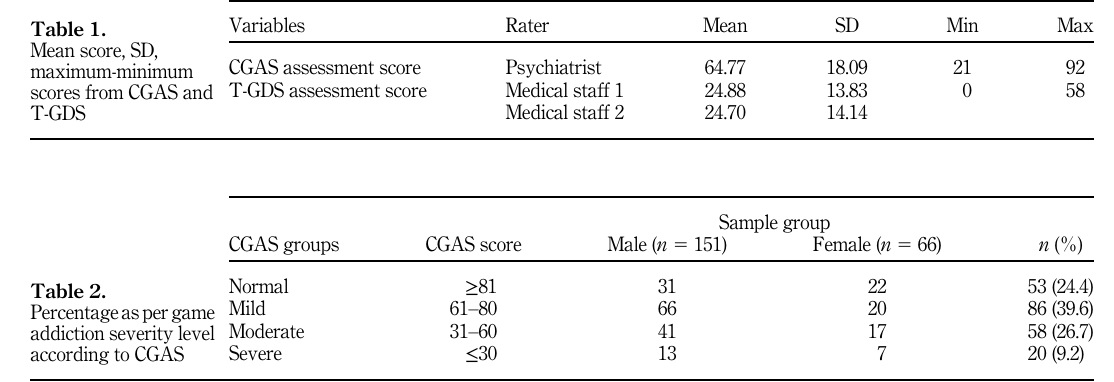
Table 2. Percentageaspergame addiction severity level according to